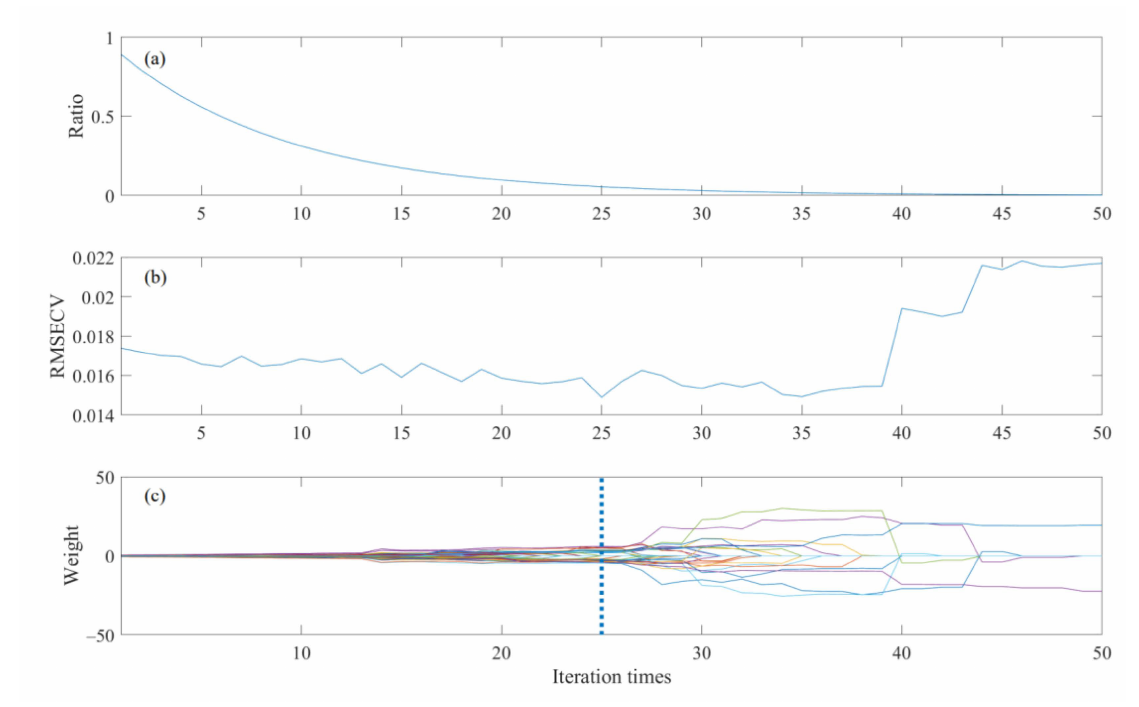
Figure 4. Process of the CARS characteristic variable selection. ( a ) Variable retention rate; ( b ) change in RMSECV; ( c ) the trend of the variable regression coefficient. Table 4. Results of the CARS and CC-CARS characteristic variable